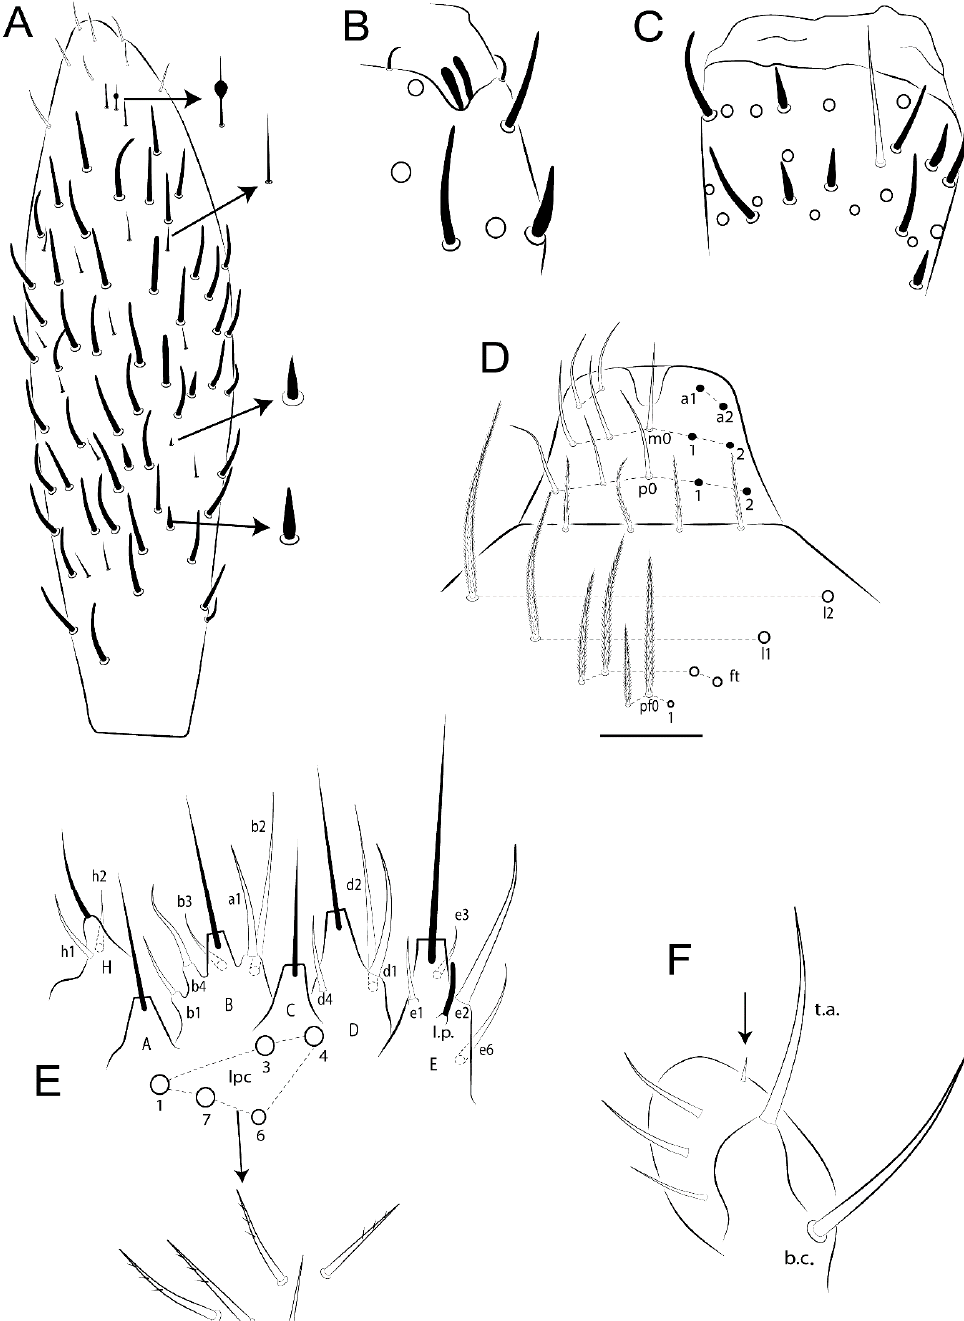
Figure 12. Pseudosinella brumadinhoensis sp. nov.: head. ( A ) Ant IV dorsal chaetotaxy, arrows indicate different types of sens; ( B ) Ant III apical organ (lateral view); ( C ) Ant III ventrodistal chaetotaxy; ( D ) chaetotaxy of clypeus, prelabrum, and labrum; ( E ) Labial papillae A–E and proximal chaetae; ( F ) maxillary palp and sublobal plate (right side), arrow indicates minute smooth appendage.